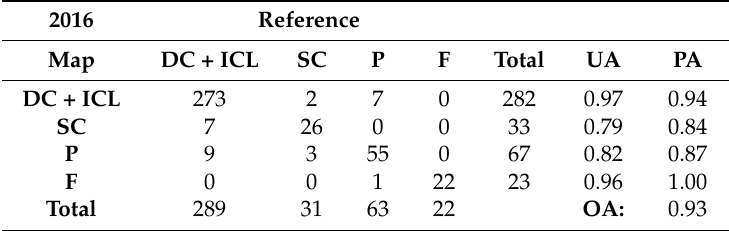
Table 6. Confusion matrices and accuracy statistics for Phase 1 classification, validation on field data.